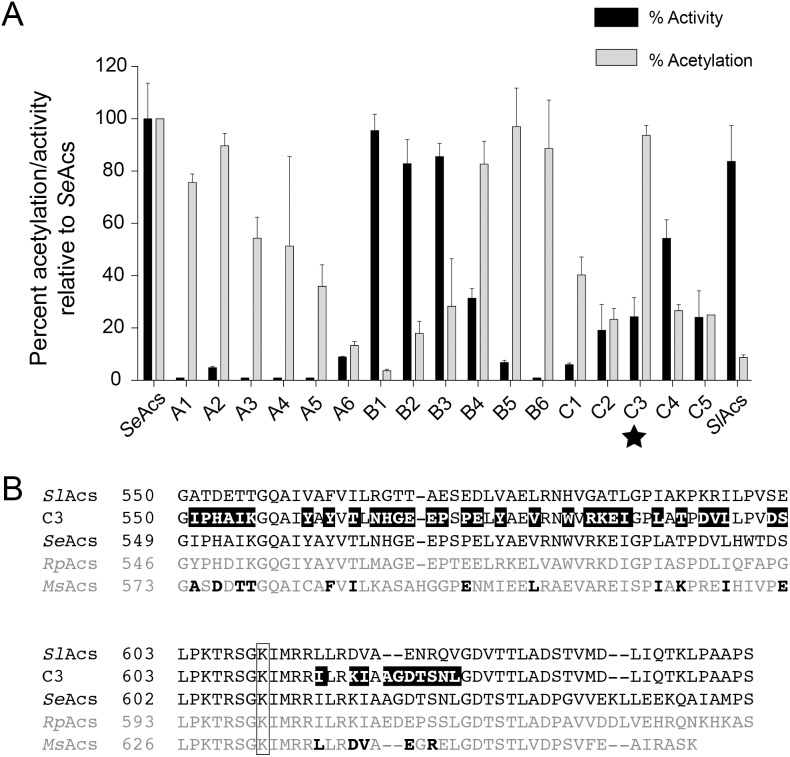

SlAcs-SeAcs Chimera C3 is active and efficiently acetylated.A. Acetyl-CoA synthetase activity of each chimera and SlAcsWT relative to SeAcsWT (gray bars). Amount of acetylation in figure 3C and 3F was quantified and normalized to the total acetylation of SeAcs (black bars). SlAcs-SeAcs chimera C3, the most efficiently acetylated, active chimera with the fewest SeAcsWT-derived residues, is noted with a star. Values are reported as the mean ± S.D. of three experiments. B. Sequence alignment of SlAcsWT, SeAcsWT, chimera C3, Rhodopseudomonas palustris CGA009 Acs (RpAcs), and Mycobacterium smegmatis mc2155 Acs (MsAcs). Residues in chimera C3 that are derived from the SeAcsWT amino acid sequence are highlighted in black. SlAcs residues conserved in the MsAcs homologue are shown in bold typeface in the sequence of the latter. Black box indicates the target lysine.